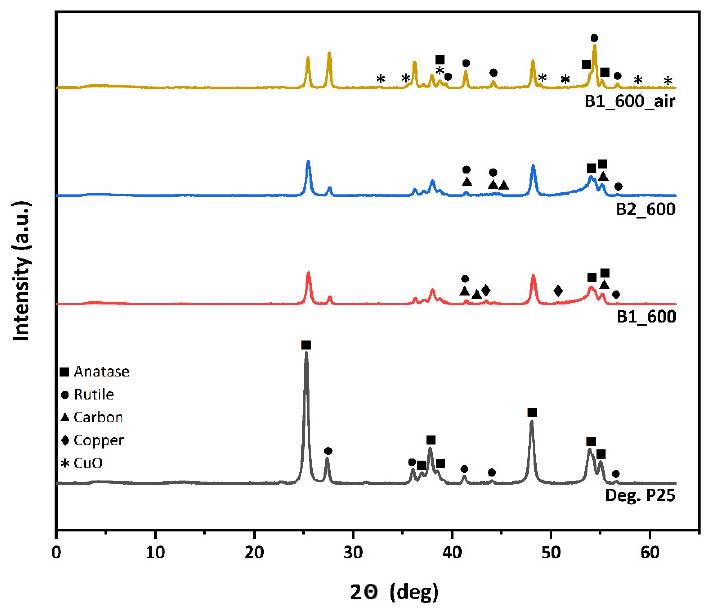
Figure 4. XRD patterns of the ceramic beads compared to Degussa P25 TiO 2 .